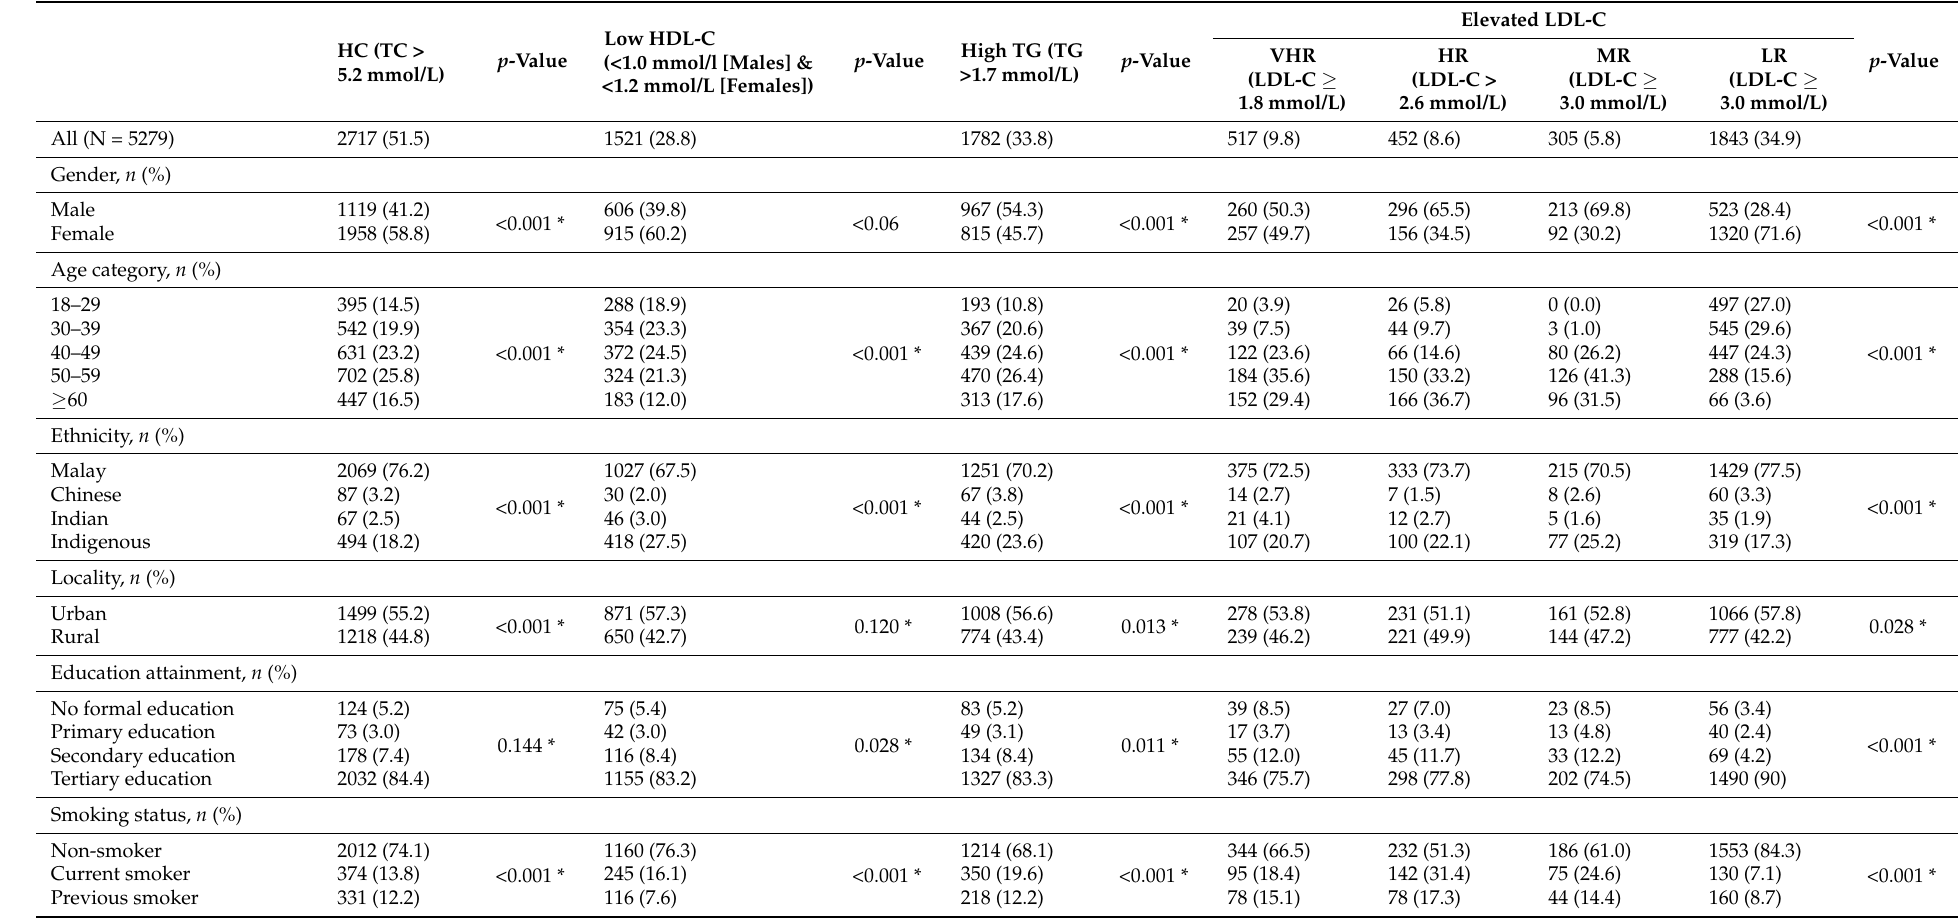
Table 2. Prevalence of dyslipidaemia subtypes according to the demographic and clinical